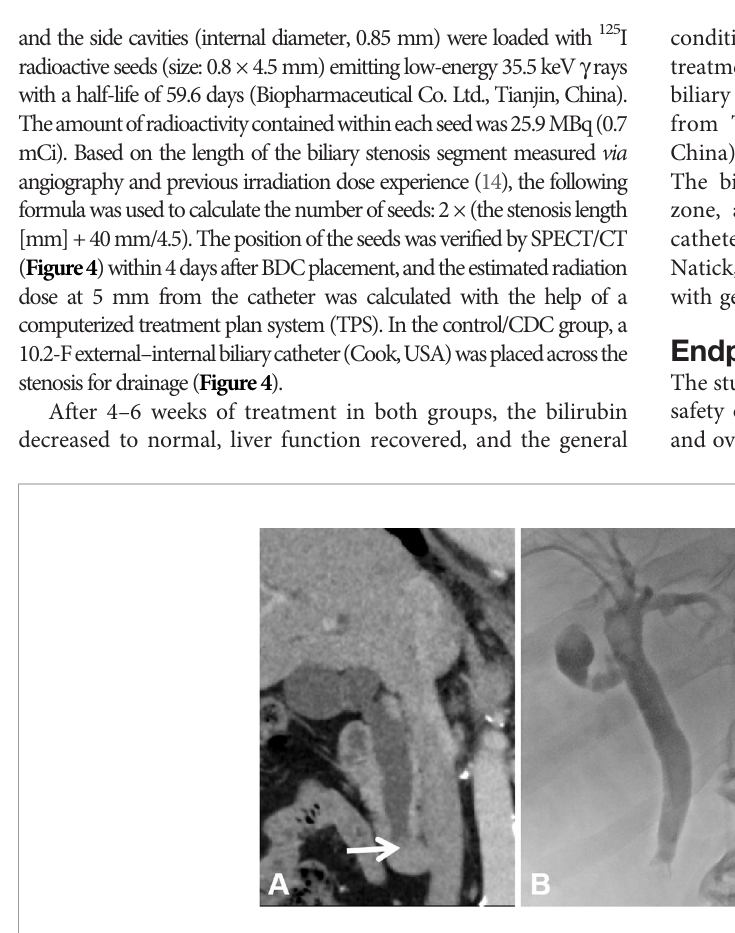
FIGURE 2 | Imaging and biopsy of the biliary obstruction. (A) Coronal enhanced CT scan showing the lower biliary obstruction caused by PC. (B) Percutaneous transhepatic cholangiography was performed to visualize the location and degree of biliary obstruction. (C) Forceps biopsy was performed at the site of the biliary obstruction via a 9-F long sheath.